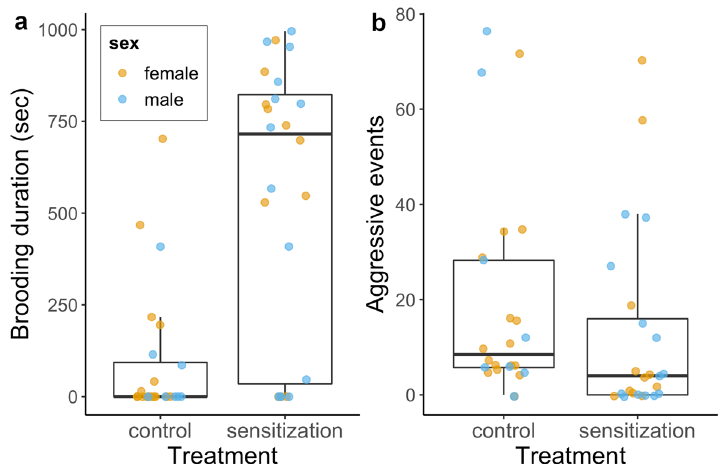
Figure 1. Brooding duration ( a ) and aggressive events (chick-directed pecking) ( b ) in animals that underwent sensitization treatment or not (control). Dots represent individual animals, coloured by sex. Reprinted from de Bruijn et al. 18 with permission from